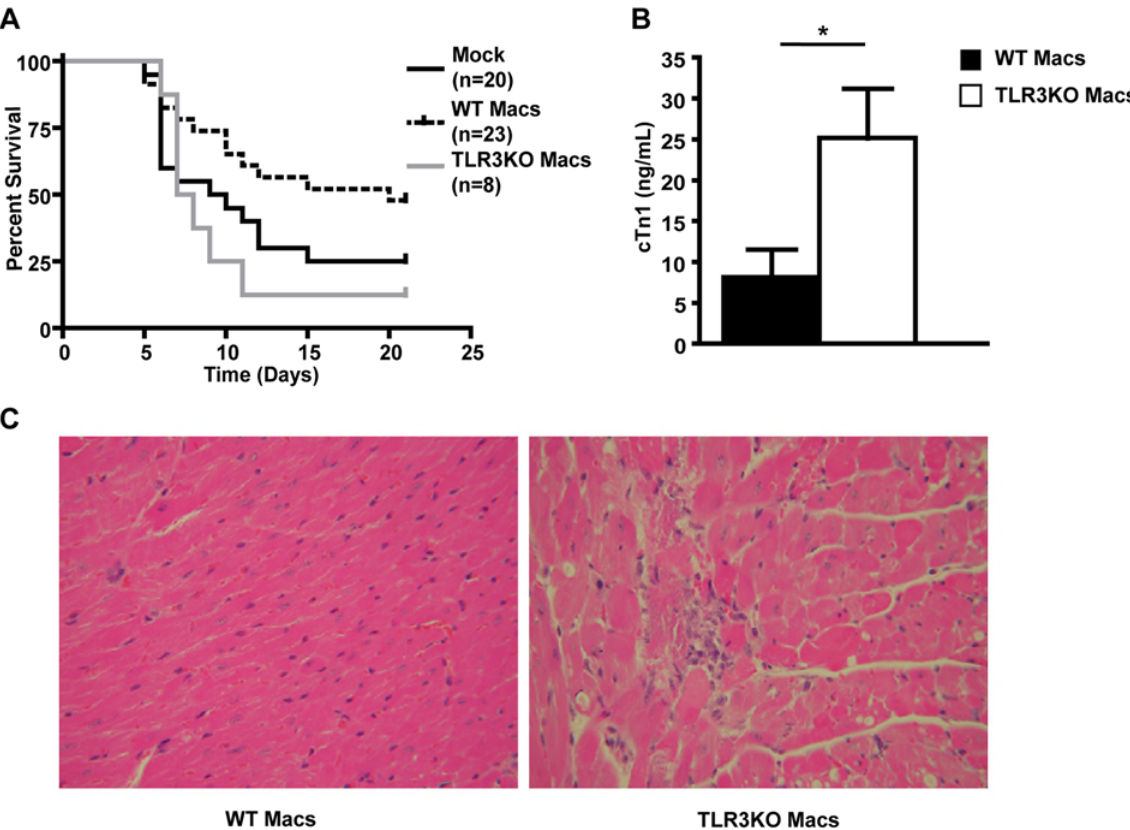
Figure 7. Adoptive transfer of WT macrophages rescues TLR3KO mice following CB4 challenge. A) TLR3KO mice were adoptively transferred with macrophages from WT NOD mice (dashed black line) or macrophages from TLR3KO mice (solid grey line) or mock-treated with DMEM (solid black line) and infected with 400 pfu of CB4 24 hours post-transfer. B) Serum cardiac troponin 1 levels of TLR3KO mice adoptively transferred with either WT NOD macrophages (black bars, n=5) or TLR3KO macrophages (white bars, n=3) at day 7 PI with CB4. Pooled data from at least 2 independent experiments are presented as mean + / 2 s.e.m. Stars denote statistical significance. C) Representative tissue section of day 7 PI hearts stained for H&E from CB4-infected TL3KO mice adoptively transferred with WT NOD macrophages (left panel) or TLR3KO macrophages (right panel).